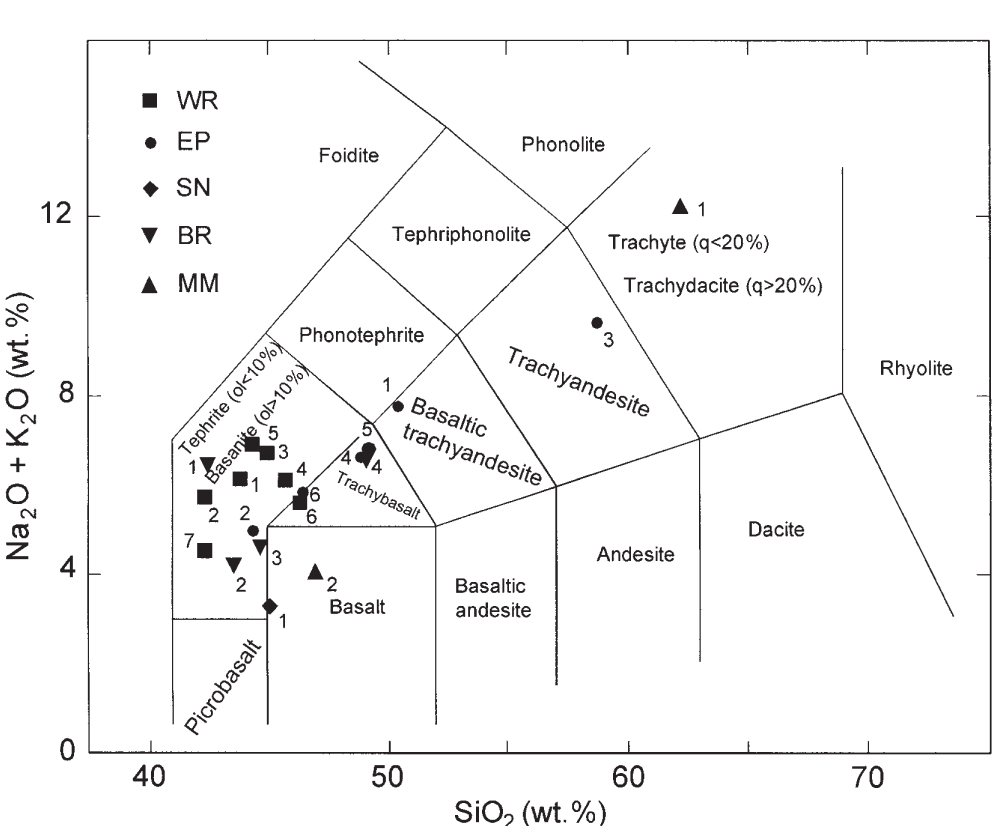
Fig. 3. Total alkali content ( Na 2 O + K 2 O ) vs. SiO 2 . Numbers at each data point correspond to those listed in table I. ol = olivine and q =